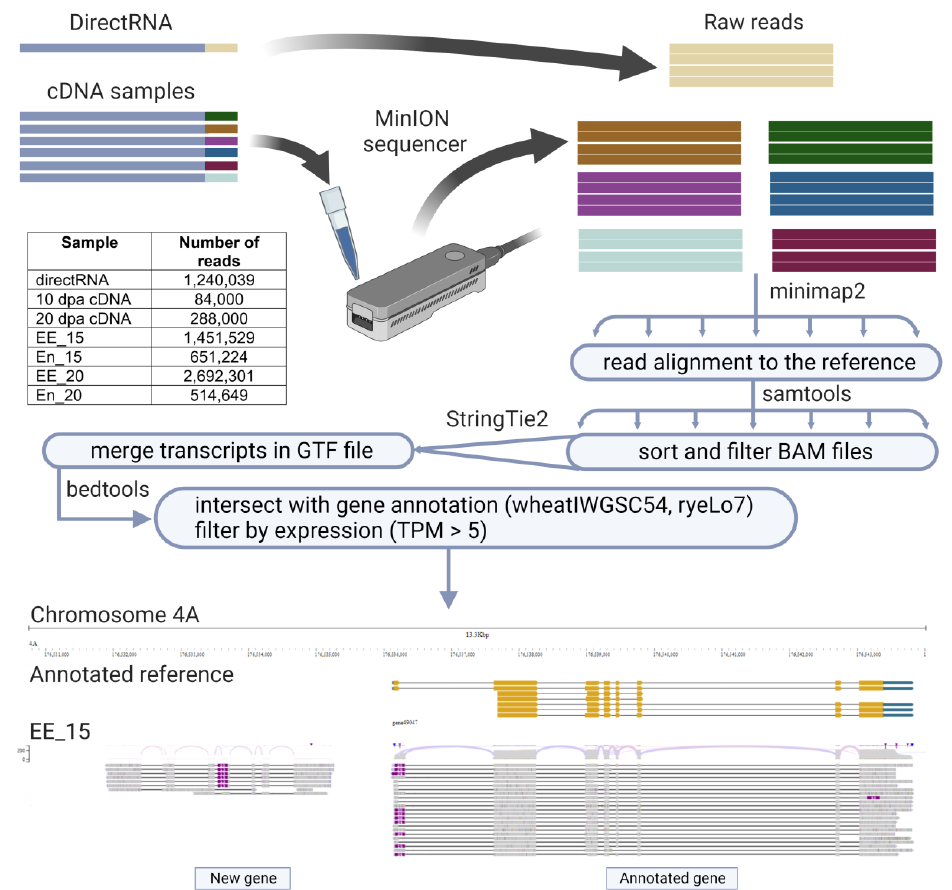
Figure 1. Experimental design and bioinformatic pipeline to find unannotated transcribed genes of the triticale. Six cDNA samples were sequenced, and the data were combined with the previous direct RNA sequencing. A snapshot of JBrowser2 of a region of Chromosome 4A with two previously unannotated genes (New gene 1 and New gene 2) is shown in the bottom.